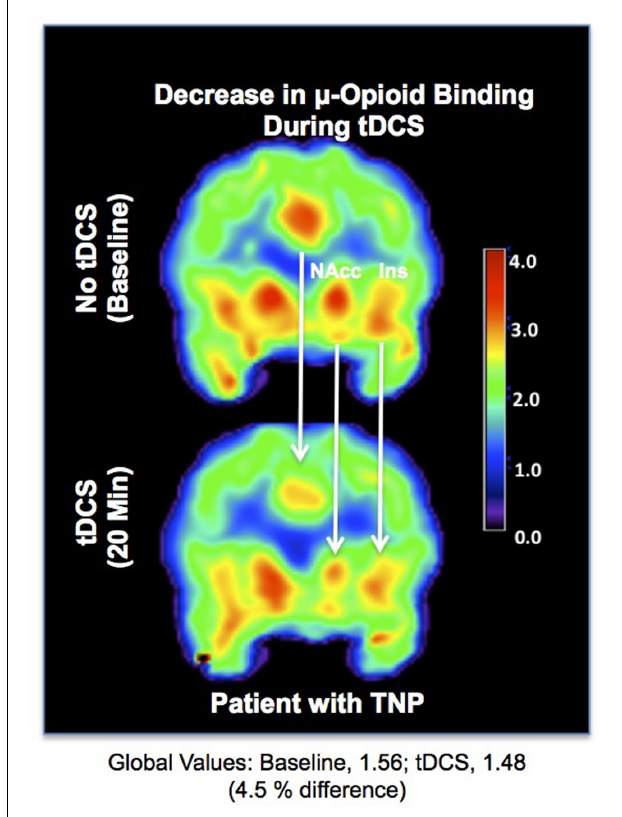
FIGURE 4 | Reduced µ OR BPND related to transcranial direct current stimulation (tDCS). (Upper) µ OR BPND during the baseline. (Lower) µ OR BPND during anodal motor cortex tDCS in the ACC, NAc, and insula (DosSantos et al.,